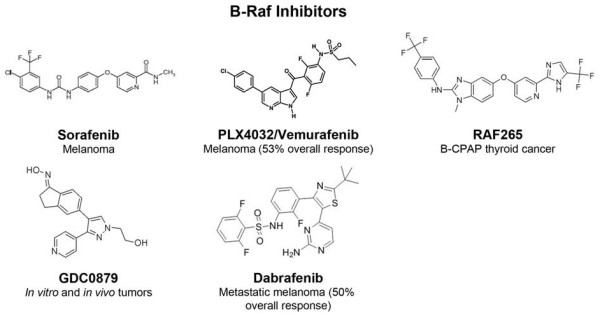
B-raf inhibitors in clinical development.